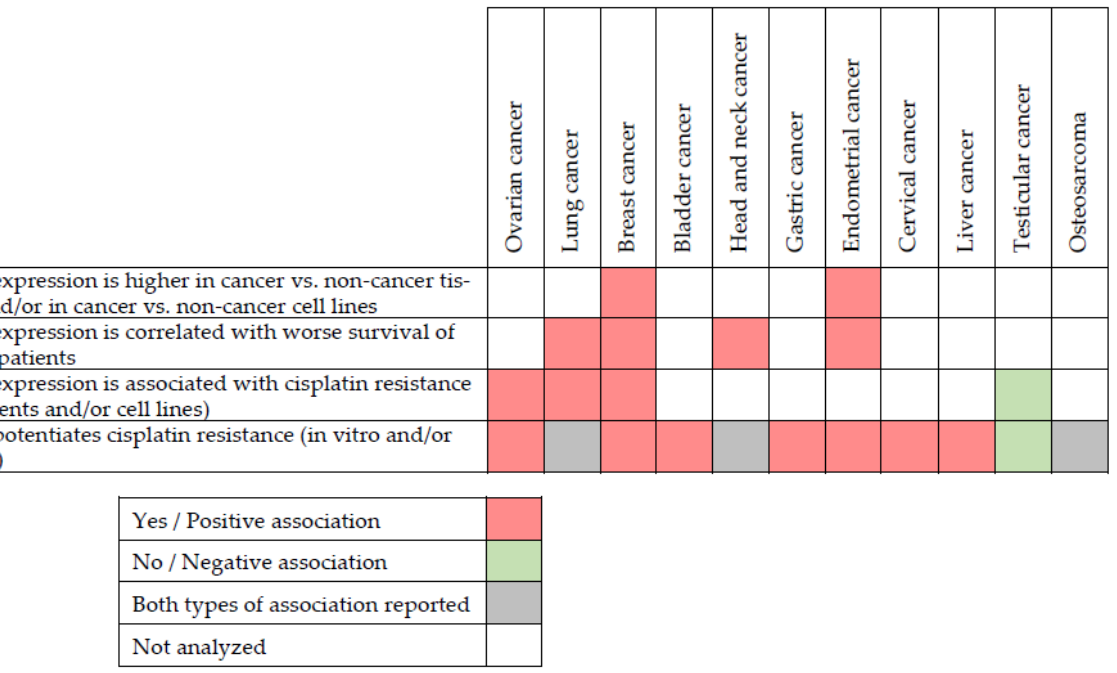
Figure 2. Summary of studies on EZH2 and cisplatin resistance in different cancer types.